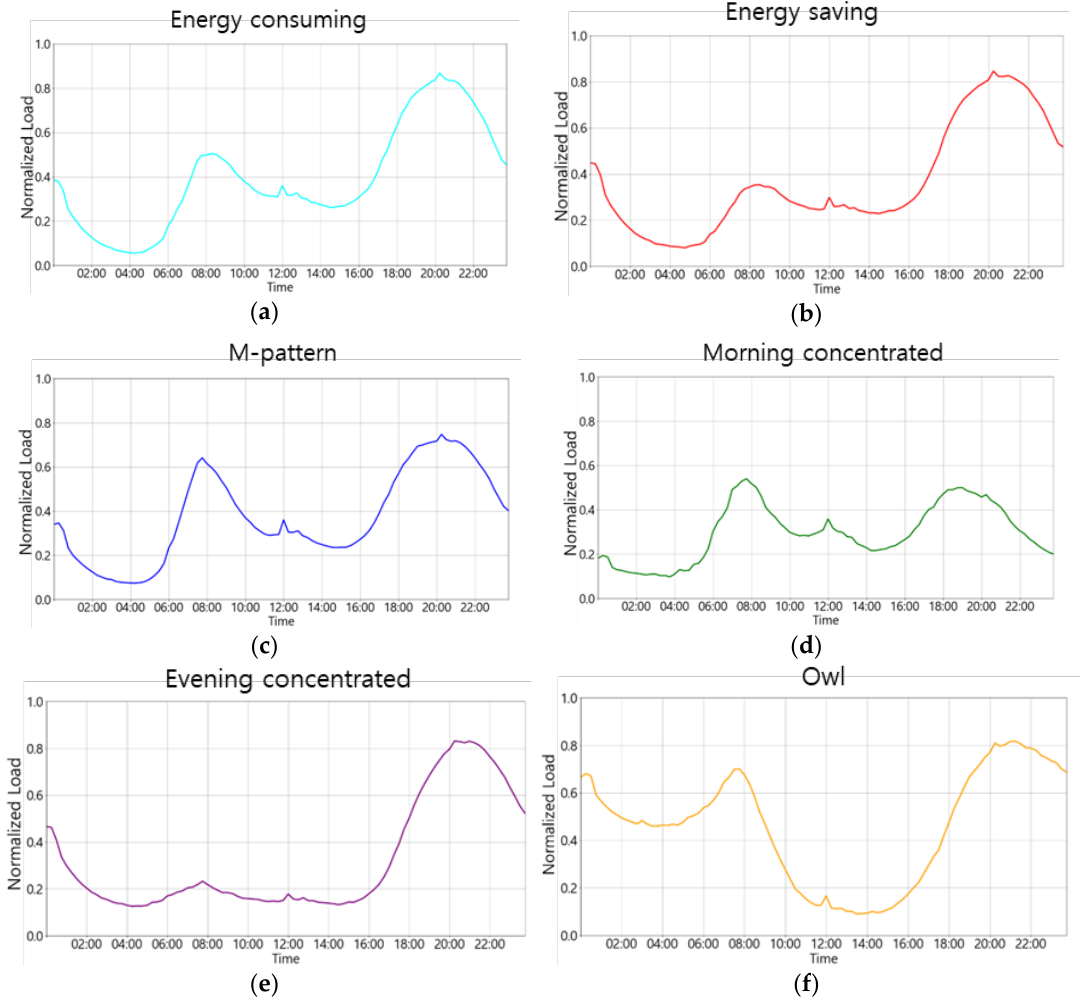
Figure 5. Results of residential customer clustering utilizing K-means. Table 4. Monthly total energy consumption and average demographic data by cluster.